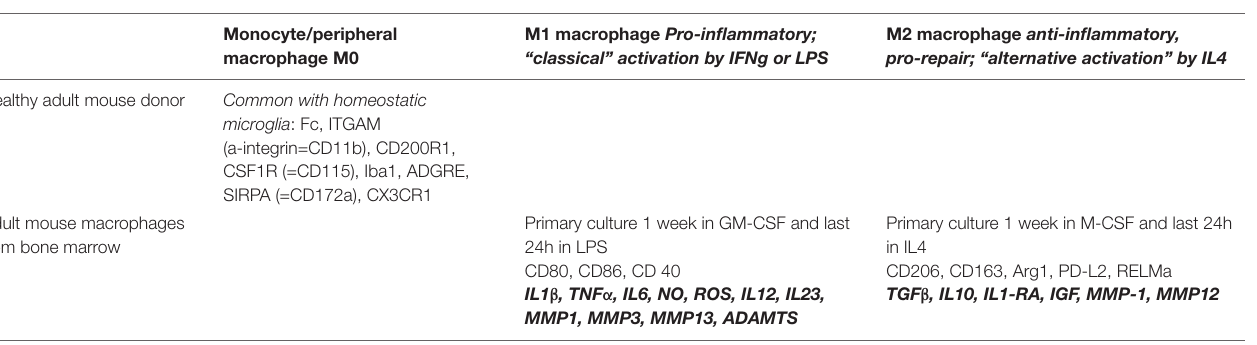
TABLE 2 | Monocytes/macrophages phenotypes.